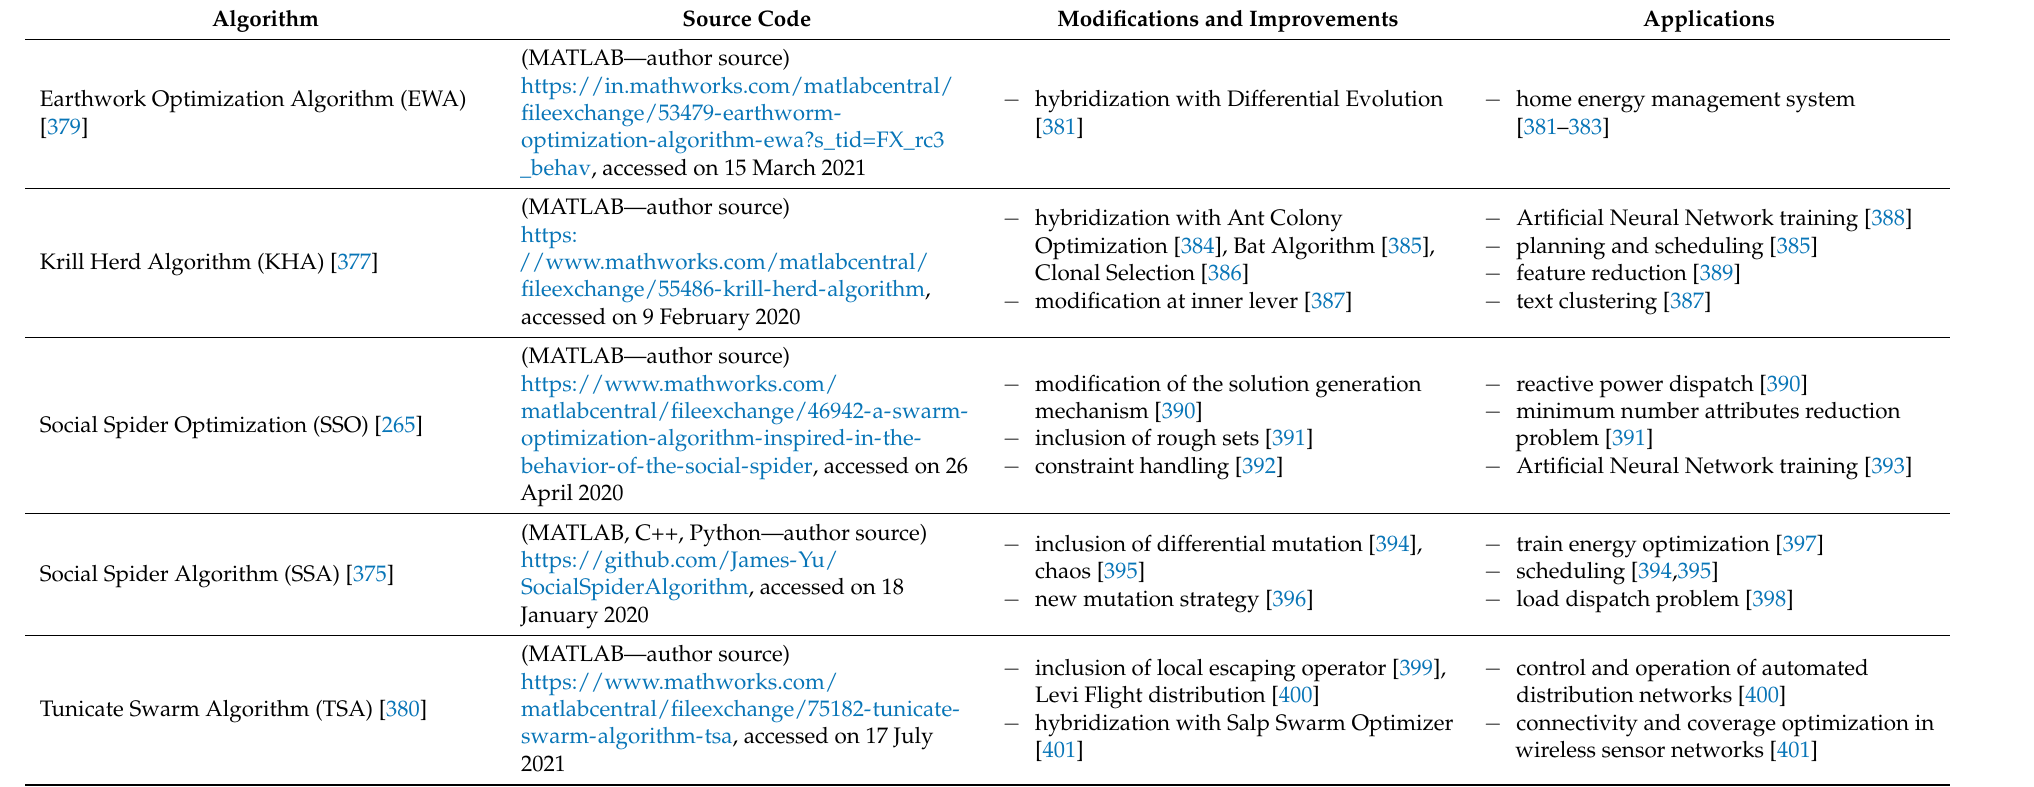
Table 5. Improvements and applications for other invertebrates-based metaheuristics (alphabetically